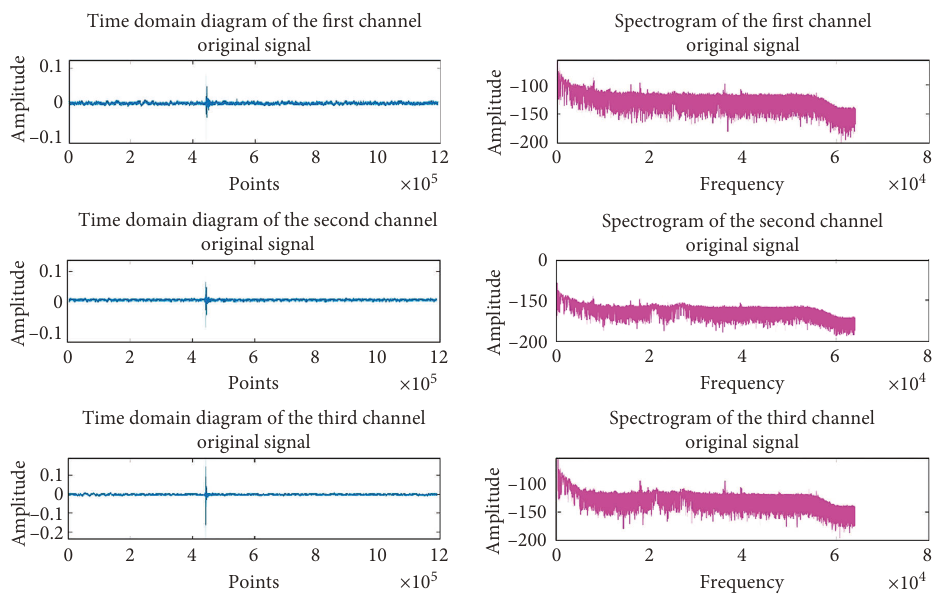
Figure 19: Time domain diagram and spectrum diagram of experimental